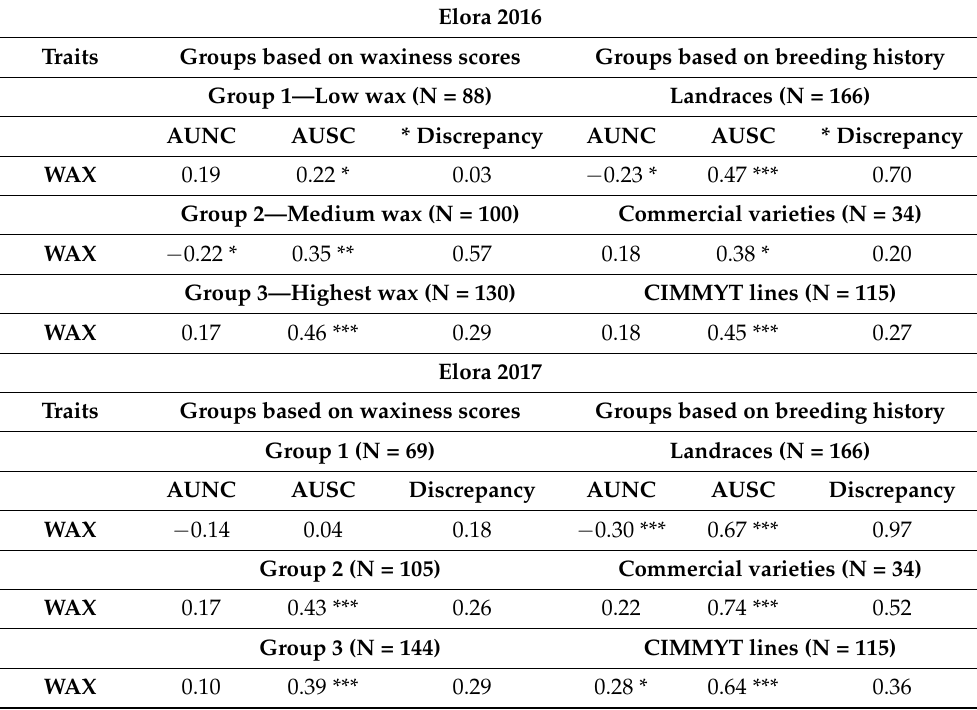
Table 4. Discrepancy observed between the correlations for waxiness with AUNC, and waxiness with